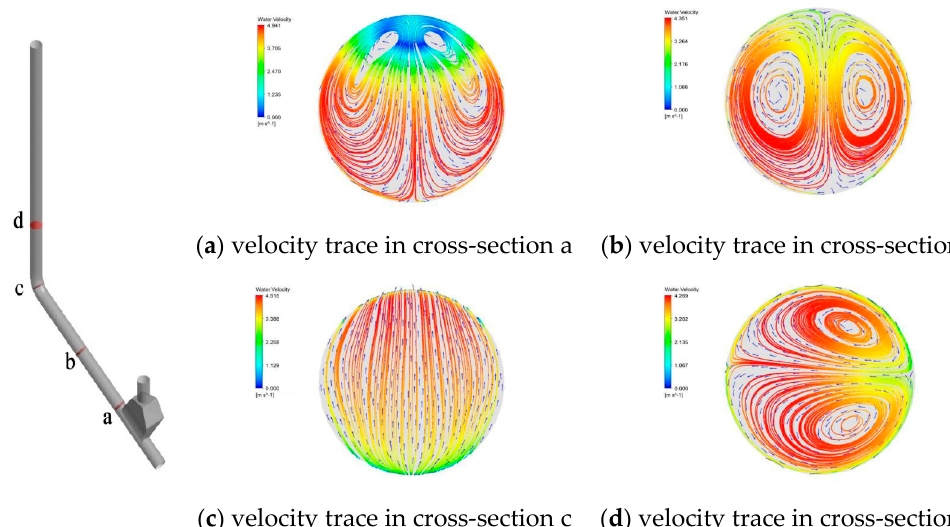
Figure 14. Secondary flows of the Y-shaped elbow at different locations in Case 3.